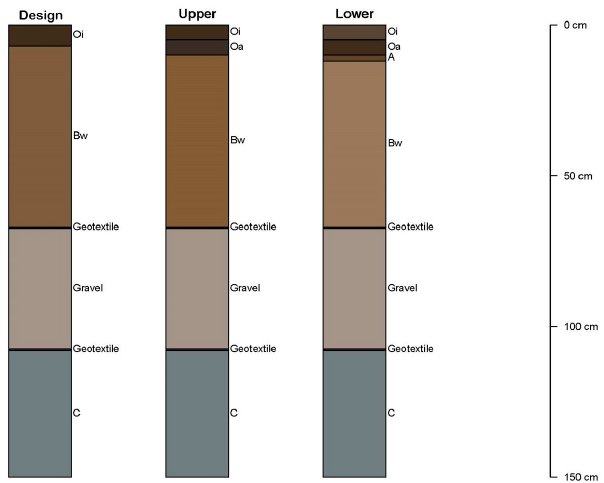
Figure 2. Profile plots indicate Munsell color, horizon, and depth of horizon for design that the 2011 install was based on and the observed field soil profiles for the upper and lower sections of the rain garden network in 2015.